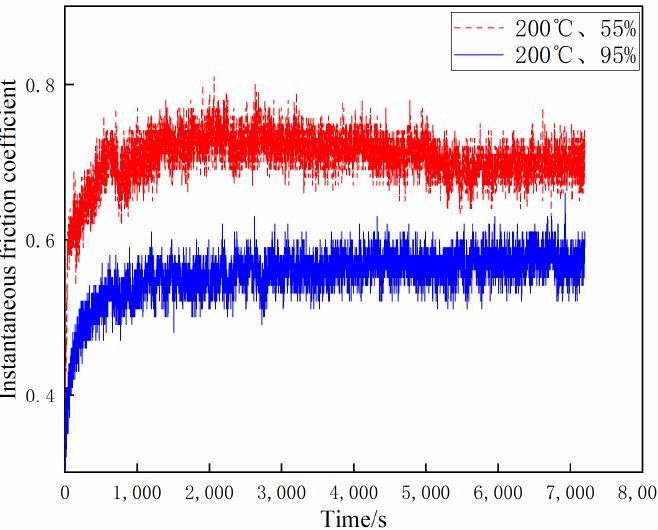
Figure 8. Friction coefficient diagram for different ambient humidity at 100 °C.